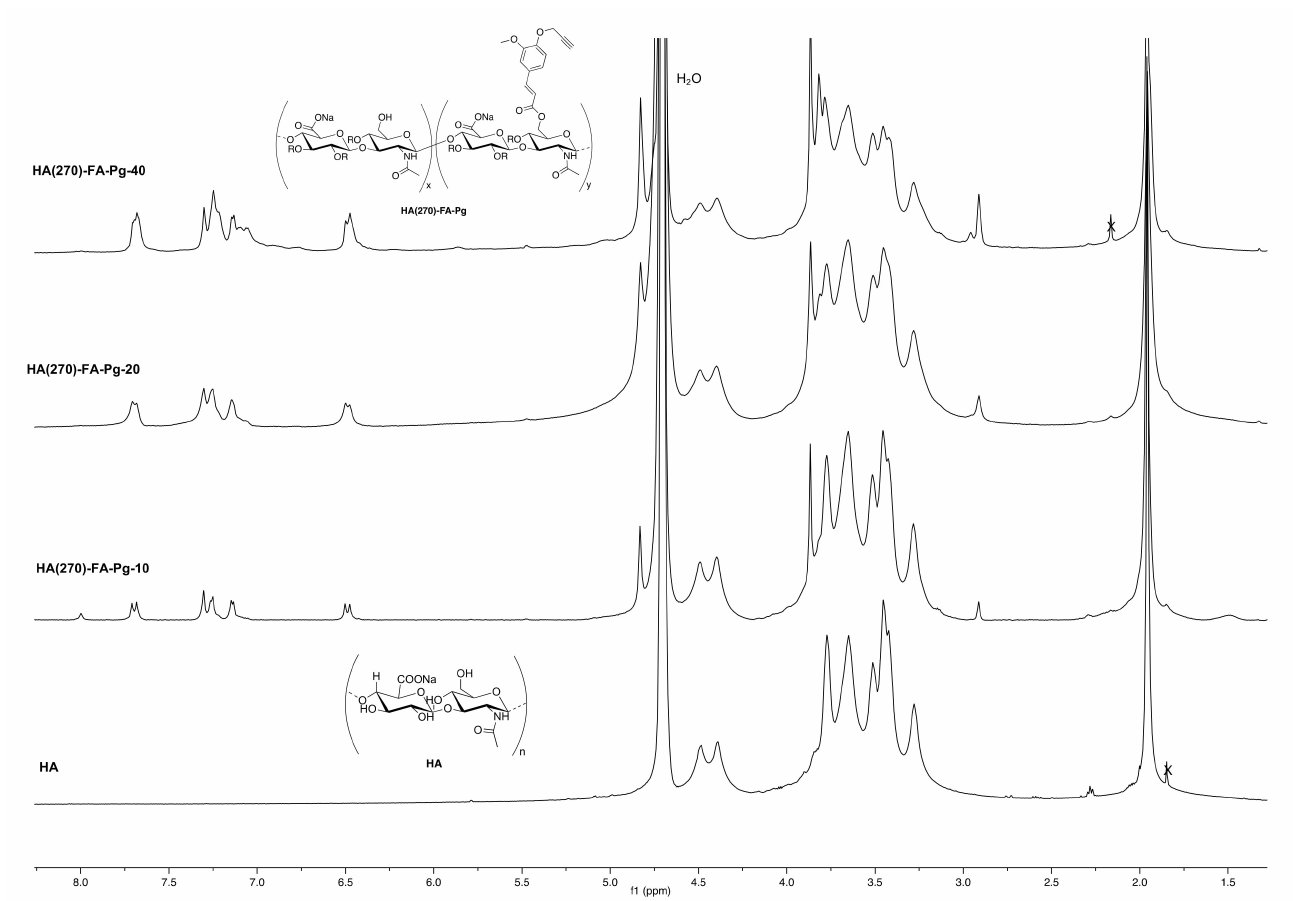
Figure 3. 1 H NMR spectra obtained with the three newly synthesized HA(270)-FA - Pg graft copoly- mers (D 2 O, 600 MHz) compared with that obtained with a starting HA